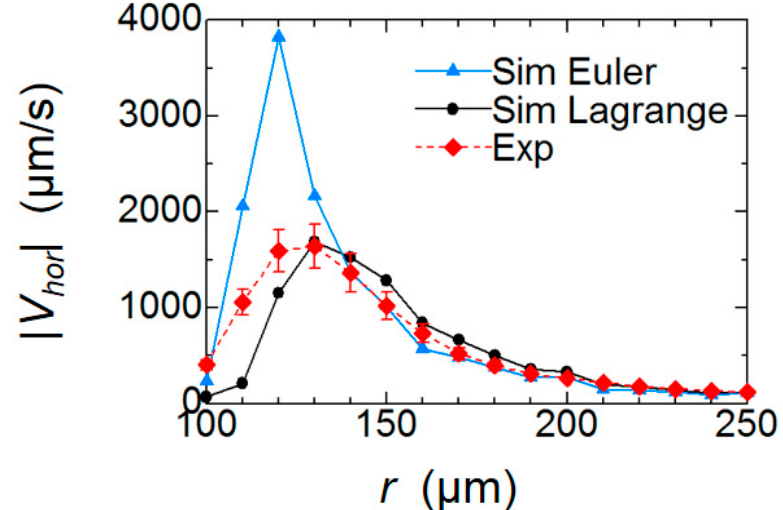
Figure 9. Distribution of the mean horizontal velocity magnitude of particles in radial direction. ( ▲ ) Eulerian averaging and ( ● ) Lanrangian averaging of the simulation result. ( ◆ ) PIV measurement. PIV was repeated three times with different setup, and the average and standard deviation are shown.